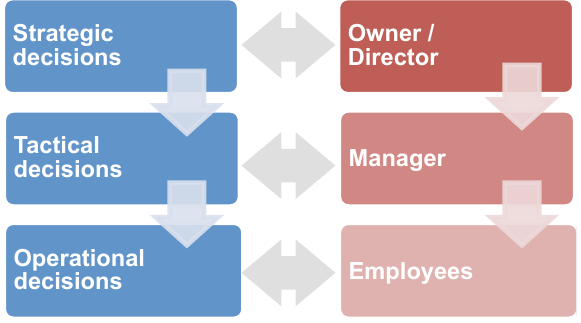
Figure 4. Strategic decisions are usually made by farm owners or directors; tactical management decisions are made by crop managers while operational decisions are mainly made by the employees responsible for the prac - tical implementation of crop protection measures. There - fore, the IPM framework of Figure 2 will work only if all the decision makers (owners, directors, employees) are in positions to decide on the most appropriate measures (modified from Bowett, 2012).